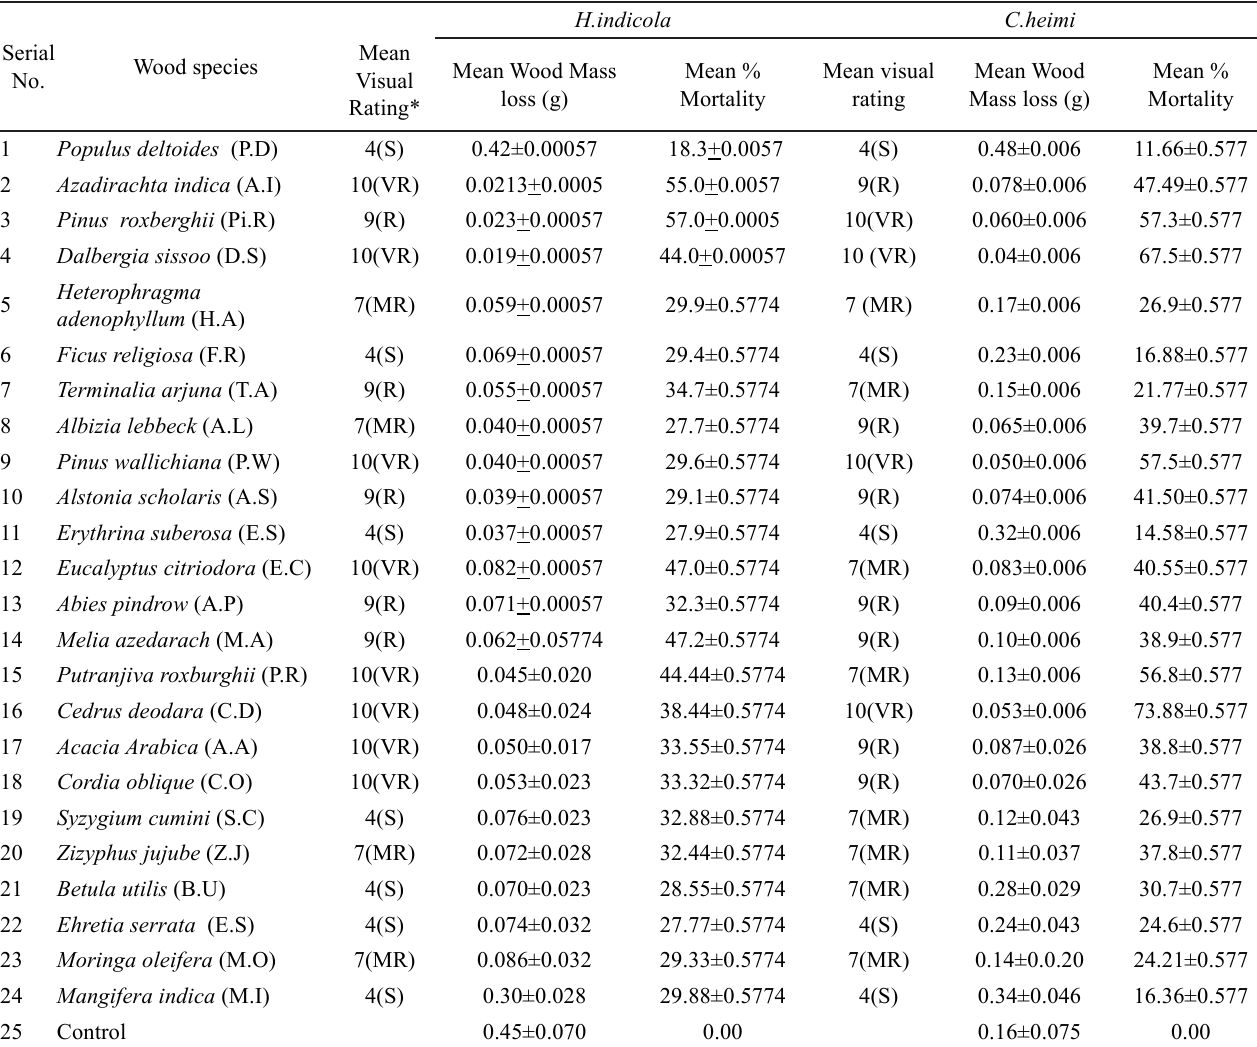
Table 1. Mean Visual Rating, Mean Wood Mass loss and mean percentage mortality of different wood species during (No Choice feeding) bioassay against H. indicola (Wasmann) and C. heimi (Wasmann) workers exposed under laboratory